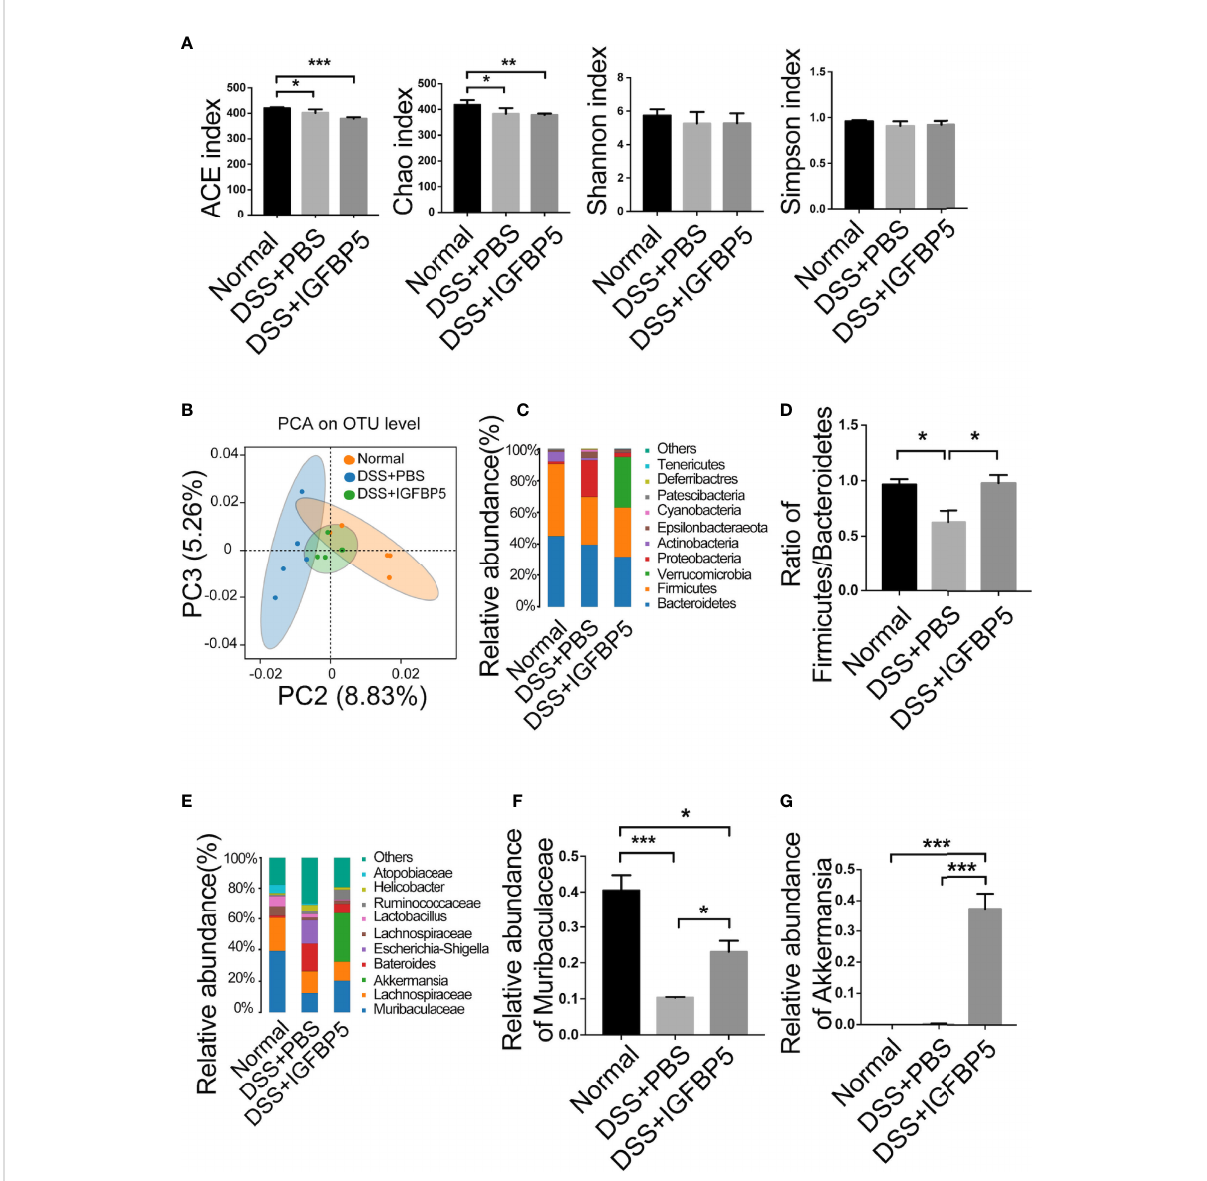
FIGURE 6 IGFBP5 regulated gut microbiota in DSS-induced colitis. Fresh stools were collected when the mice were sacri fi ced on Day 7, and DNA was extracted for 16S rDNA sequencing. The alpha diversity index of the gut microbiota was shown in (A) ACE, Chao, Shannon and Simpson index. (B) PCA of the intestinal microbiota at the OTU level in mice. PC2 and PC3 exhibited 8.83% and 5.26% of the variation, respectively. (C) Relative abundance of bacteria at phylum levels (>1%) in Normal, DSS+PBS and DSS+IGFBP5 group. (D) The Firmicutes/Bacteroidetes ratio at the